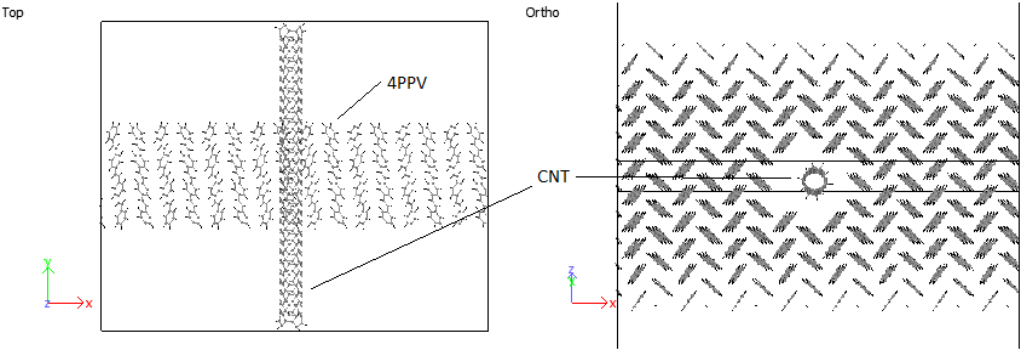
Figure 27. Interaction: 4PPV-SWCNT (initial).